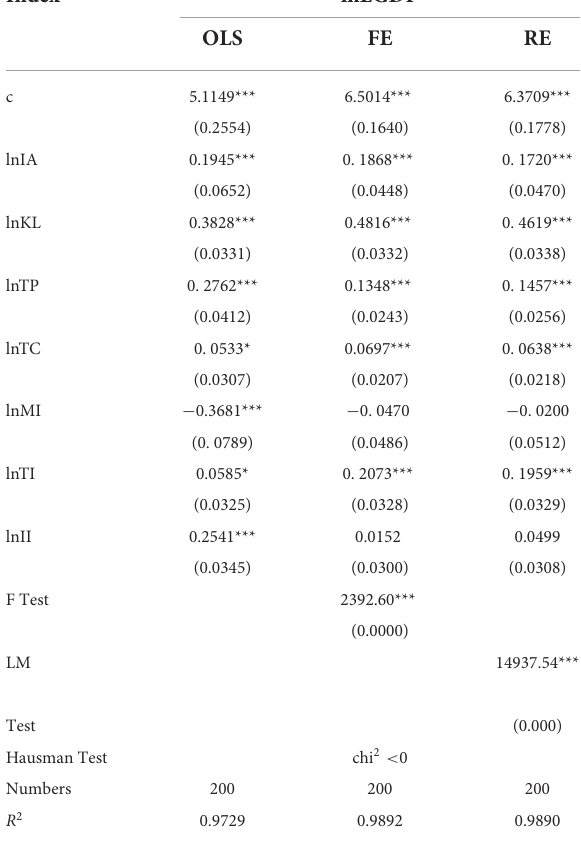
TABLE 5 Regression results of LUEE (lnLGDP, single factor